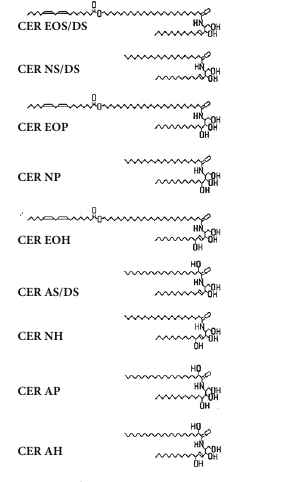
Figure 2: Structures of free ceramides from human stratum corne- um